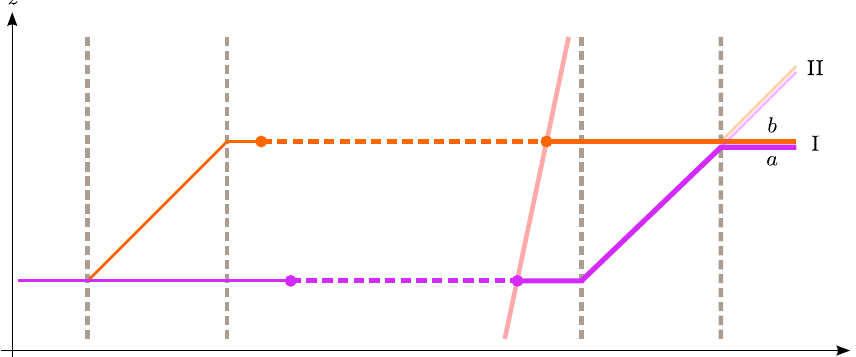
FIG. 7. In the freely falling frame, the proper-time difference between the dashed segments in the doubly differential measurement is a consequence of the lack of simultaneity for the spatial hypersurfaces associated with the initialization